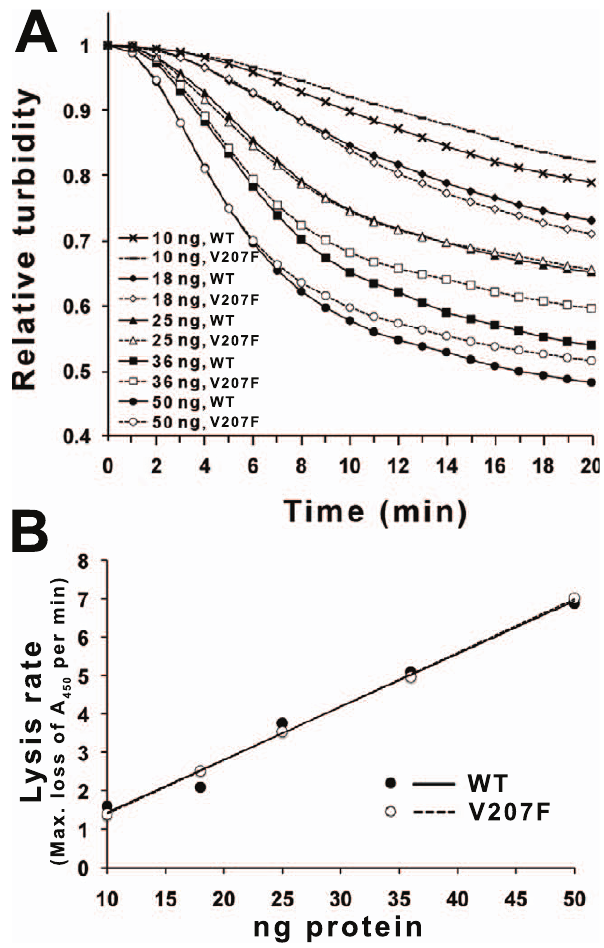
Figure 5. Cell wall lysis activity of P5 wt and P5 V207F . A) To measure the cell lysis activities of P5 wt and P5 V207F the turbidity of chloroform-treated E. coli was measured as absorbance at 450 nm at 25 u C. P5 wt and P5 V207F have the same maximum cell lysis rates. B) Linear relationship between the maximal rate of decrease in absorbance and the enzyme